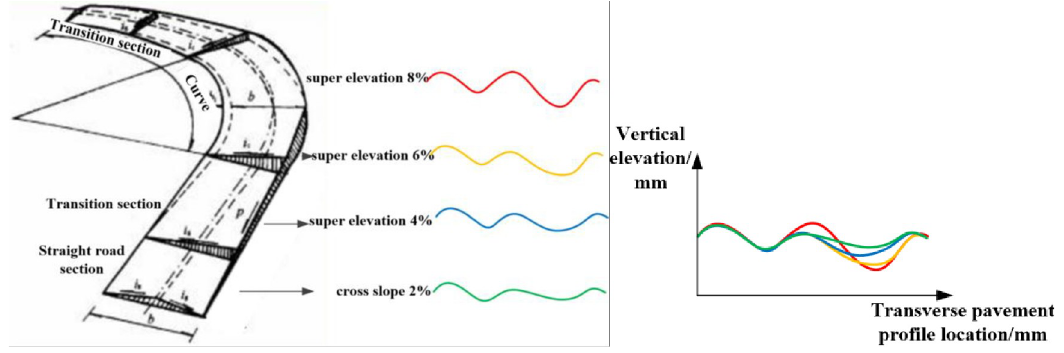
Fig 1. Ruts on straight and curved road